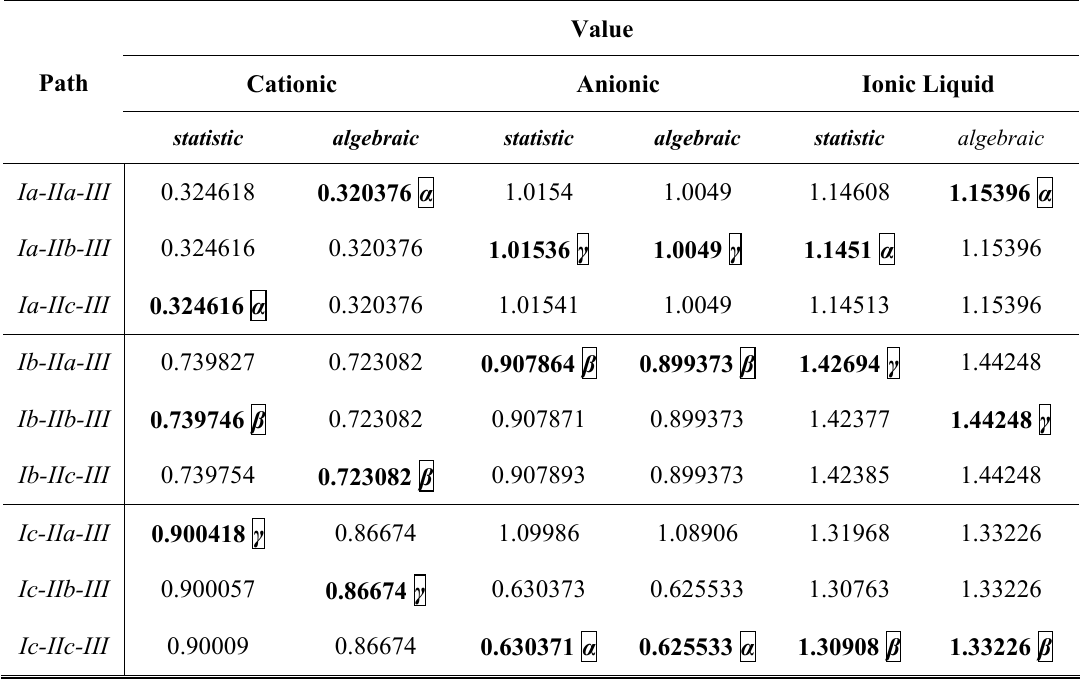
Table 7: Synopsis of the statistic and algebraic values of paths connecting the S-SAR models of Table 5, in the norm-correlation spectral-space of Figure 3, for the ionic liquids of Figure 2 against Vibrio fischeri toxicity. The primary, secondary and tertiary - the so called alpha ( α ), beta ( β ) and gamma ( γ ) paths, are indicated according to the least path principle in spectral norm-correlation space with the statistic and algebraic variants of the correlation factors used,